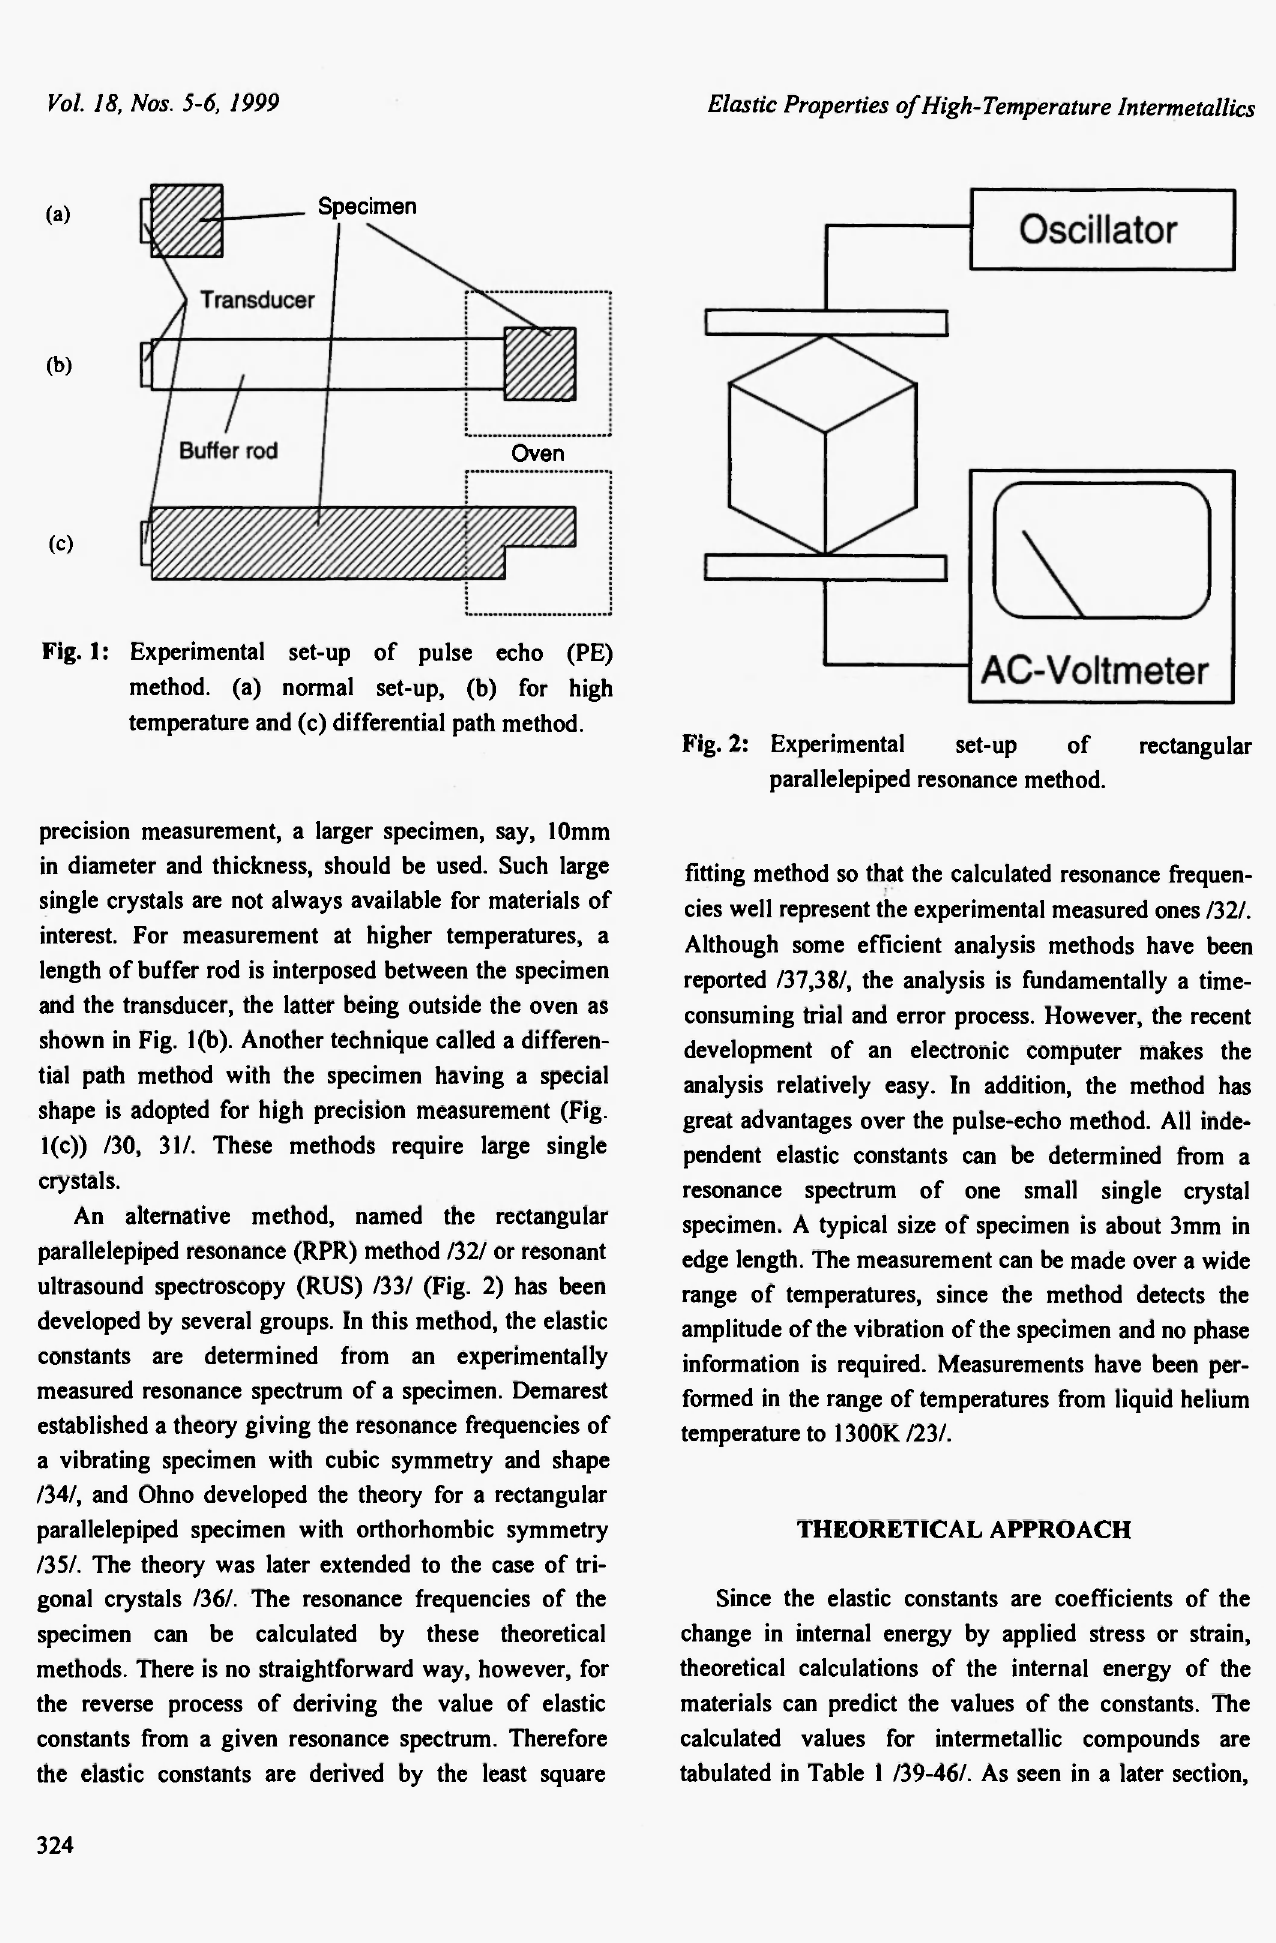
Fig. 2: Experimental set-up of rectangular parallelepiped resonance